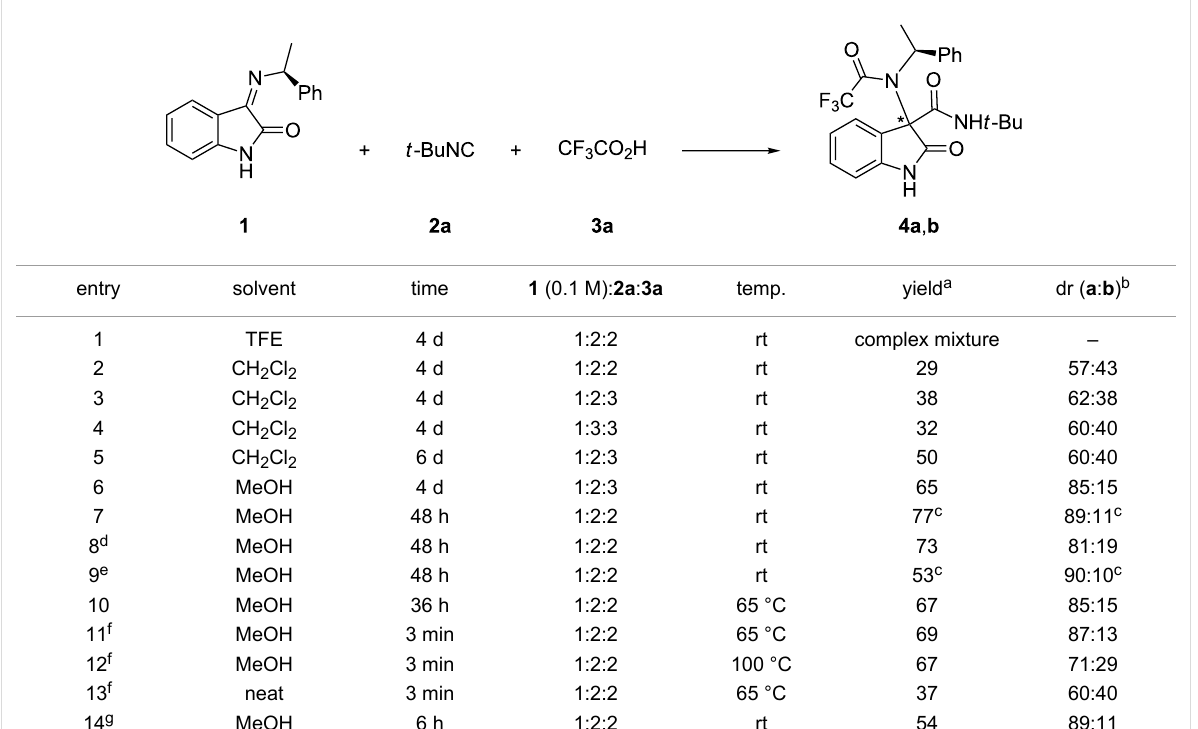
Table 1: Optimization of reaction conditions for the U-3CR of 1 with tert -butyl isocyanide and TFA.